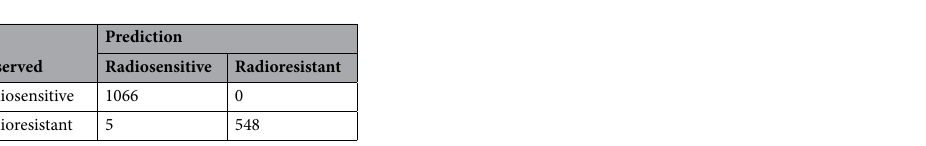
Table 1. Random forest prediction of radiosensitivity vs.